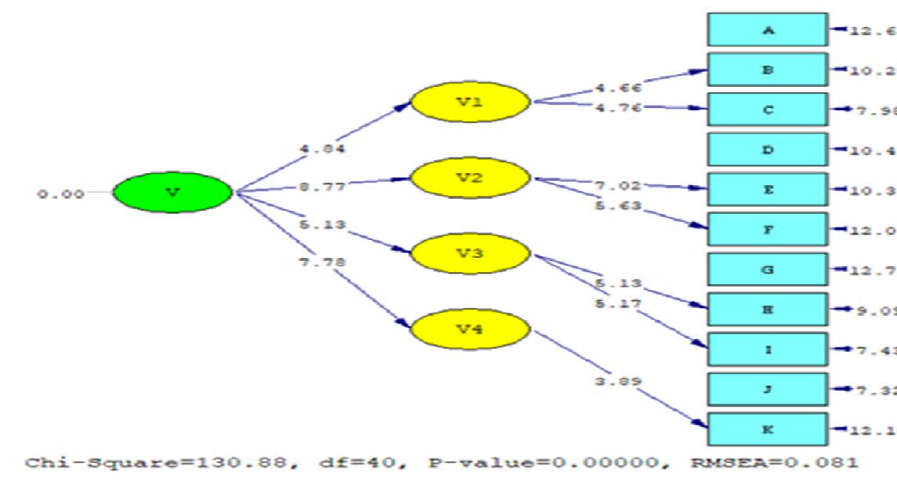
Fig. 4 : Path diagram t-values Table 6: Relationships between research variables